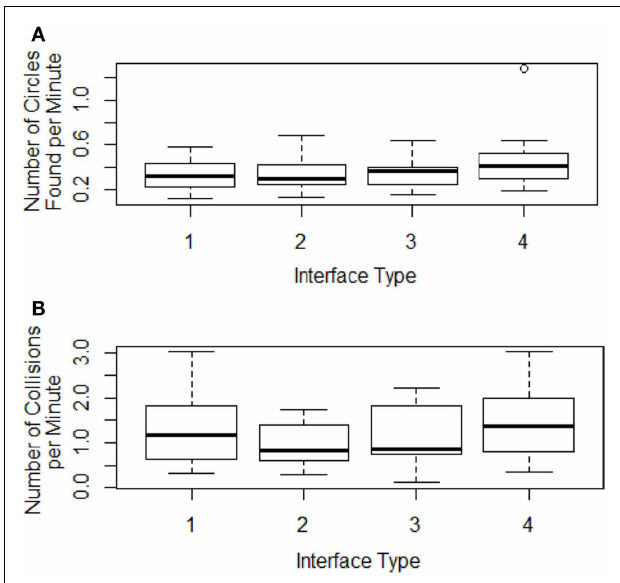
FIGURE 9 |Variations in the (A) number of circles found per minute and (B) number of collisions per minute among interface treatments .